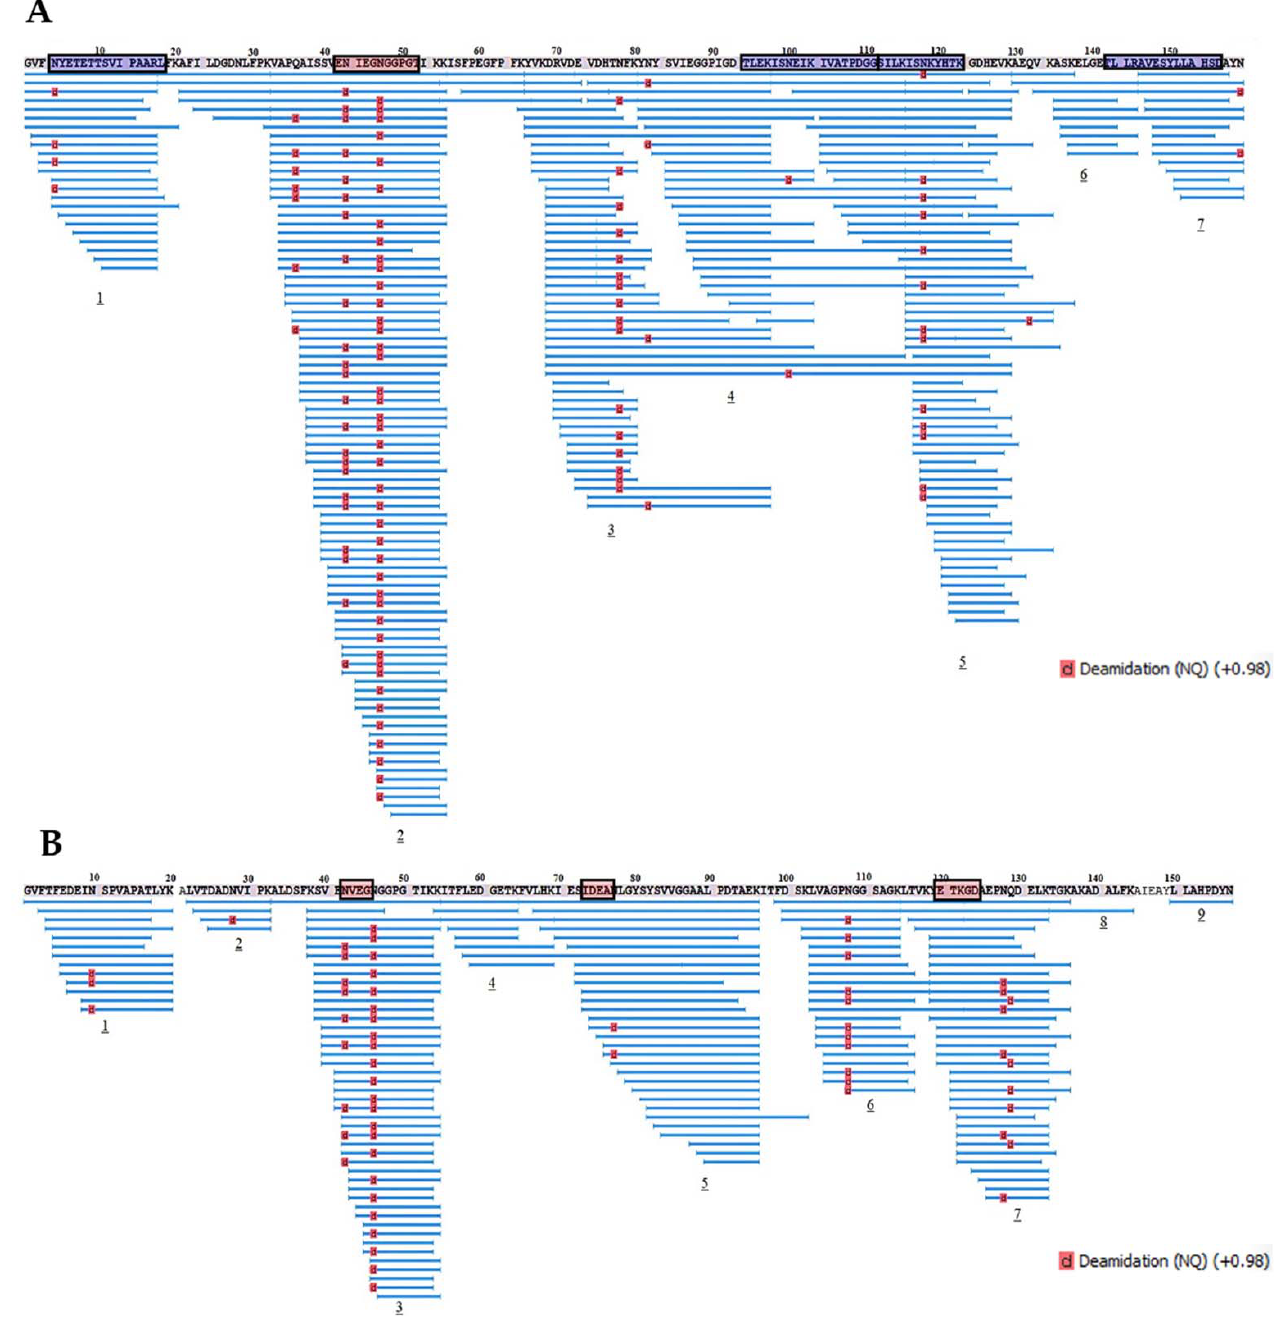
Figure 8. The fragments of Bet v 1 ( A ) and Gly m 4 ( B ) resulted from allergens degradation in vitro by lysosomal enzymes of human macrophages for 8 h. Numbers 1–9 show the main clusters of peptide fragments of the investigated birch and soybean allergens. Dominant IgE-binding linear epitopes of Bet v 1 (E 42 NIEGNGGPGT 52 , accordingly to [29]) and Gly m 4 (N 43 VEG 46 , I 74 DEAN 77 and E 121 TKGD 125 , accordingly to [23]) are framed in red. Dominant T-cell epitopes of Bet v 1 142–156 and other epitopes of Bet v 1 4–18,94–111,112–123 , recognized by at least 25% of the patients studied [28], are framed in blue.